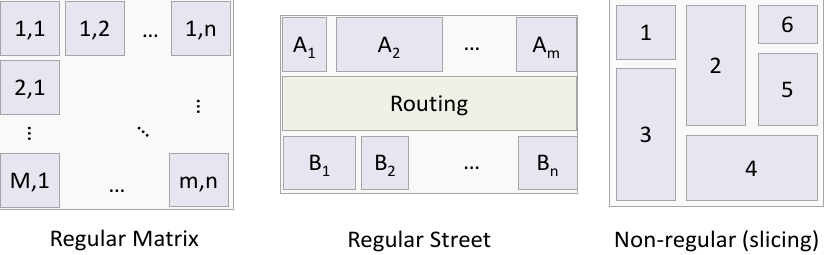
Figure 5. Comparison of exemplary template styles. The matrix and street templates are very